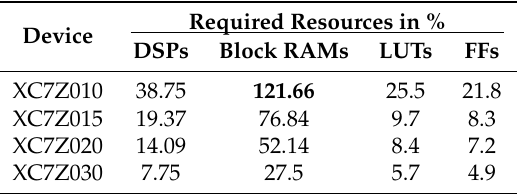
Table 4. Resources consumed by our IP compared to the available resources in Zynq